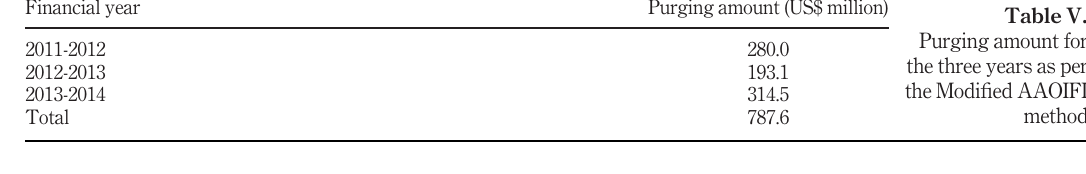
Table V. Purging amount for